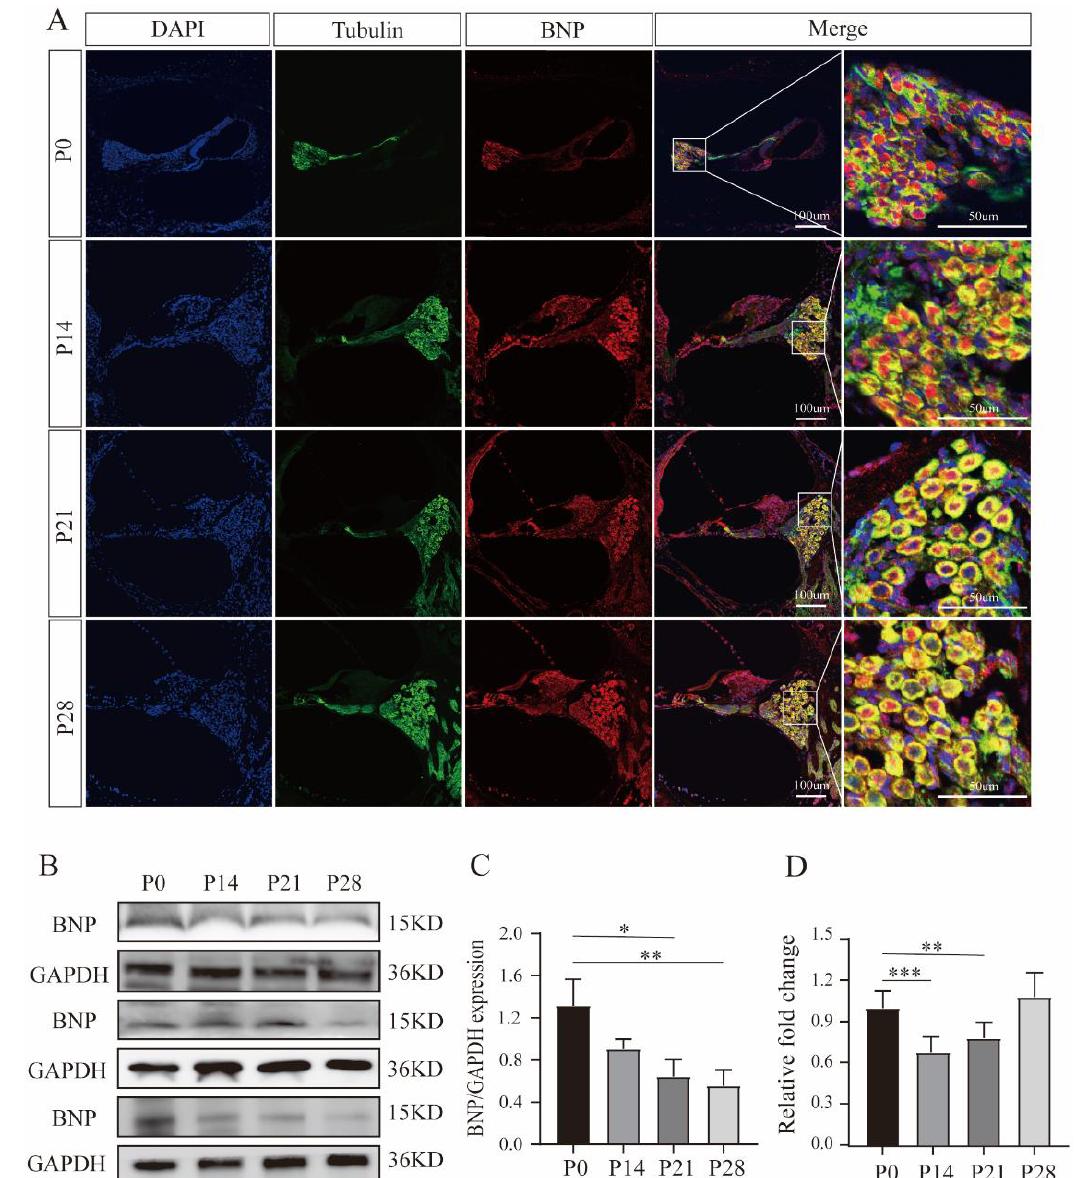
Figure 1. Expression and localization of brain natriuretic peptide (BNP) in the cochlea. ( A ) BNP is expressed in rat spiral ganglion neurons and remains unchanged during the whole